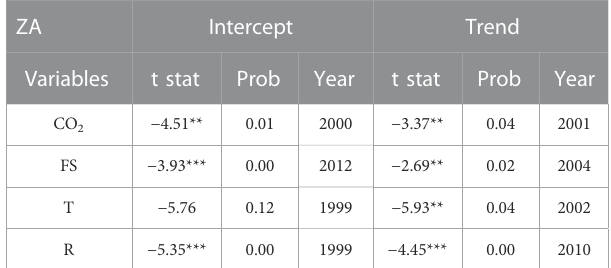
TABLE 3 Zivot andrew